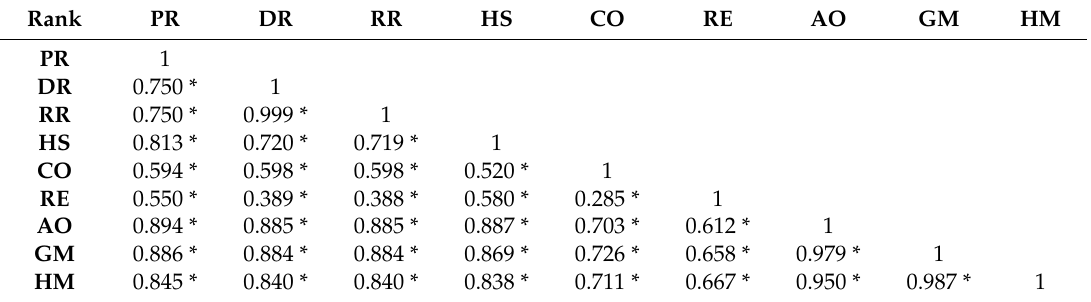
Table 3. Correlations of ordinal rankings.